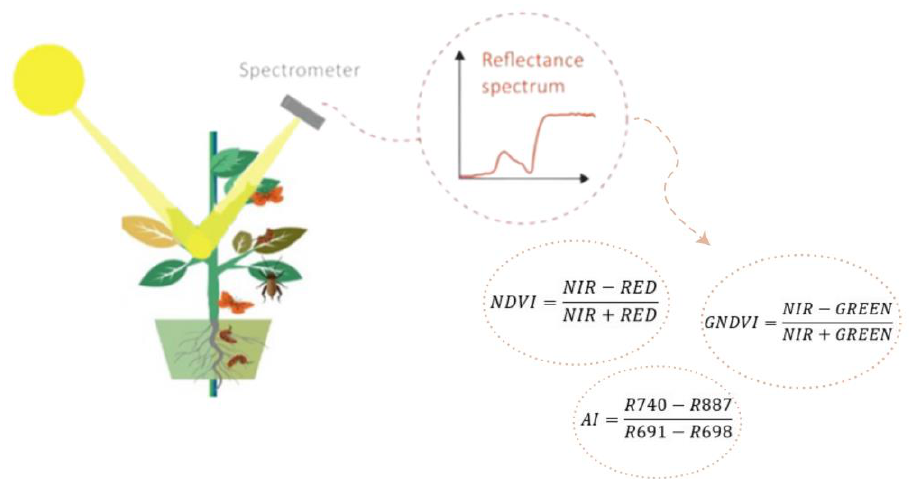
Figure 3. Method for obtaining spectral data from pest-infested plants using hyperspectral sensor (spectrometer). Vegetation indices (VI) such as NDVI, GNDVI and AI can be calculated from the reflectance spectral data.